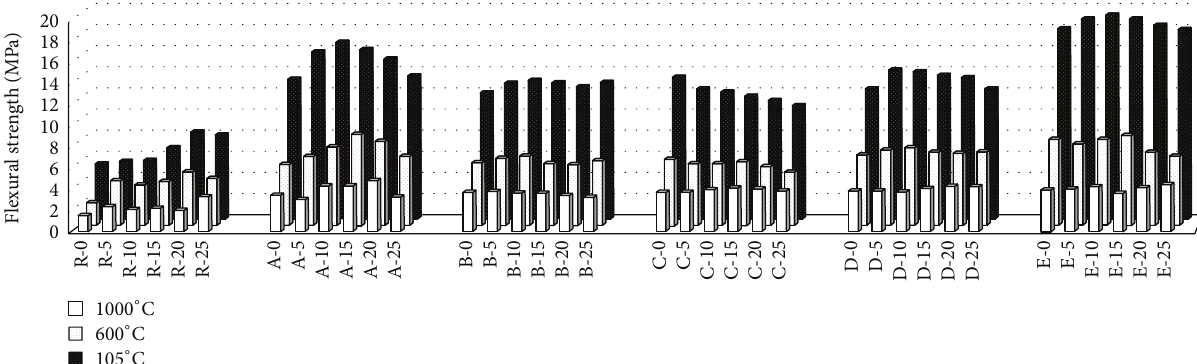
Figure 5: Impact of different composition and temperature loading on flexural strength.